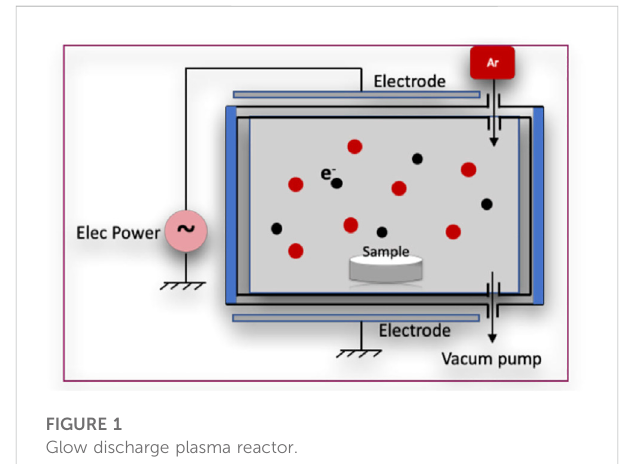
FIGURE 1 Glow discharge plasma